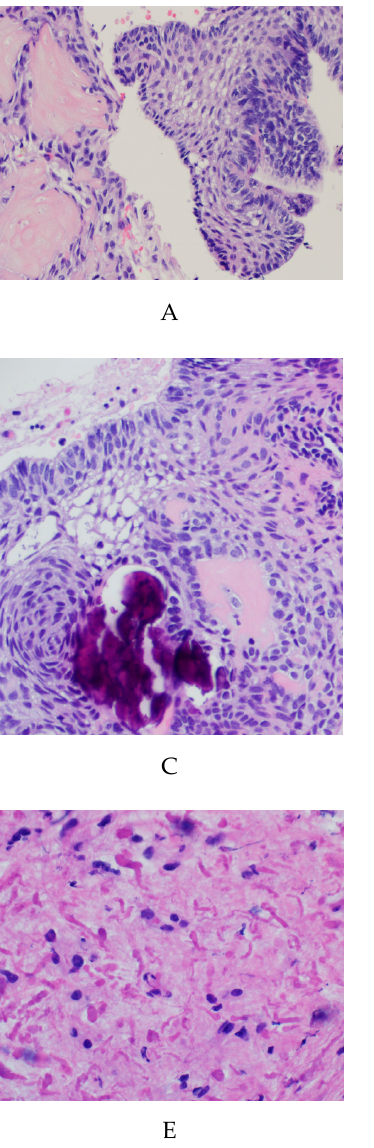
Figure 1. Classic histopathological findings in adamantinomatous craniopharyngioma: ( A ) H&E stained sections showing an epithelial tumor with palisading cells with aggregates of ‘wet’ keratin; ( B ) higher magnification view demonstrating keratinized ‘ghost cells’; ( C ) Higher magnification view demonstrating calcifications and stellate reticulum; ( D ) Immunohistochemical staining for Beta-catenin that is nuclear positive in a subset of tumor cells. ( E ) The surrounding brain parenchyma shows extensive gliosis with Rosenthal fibers.